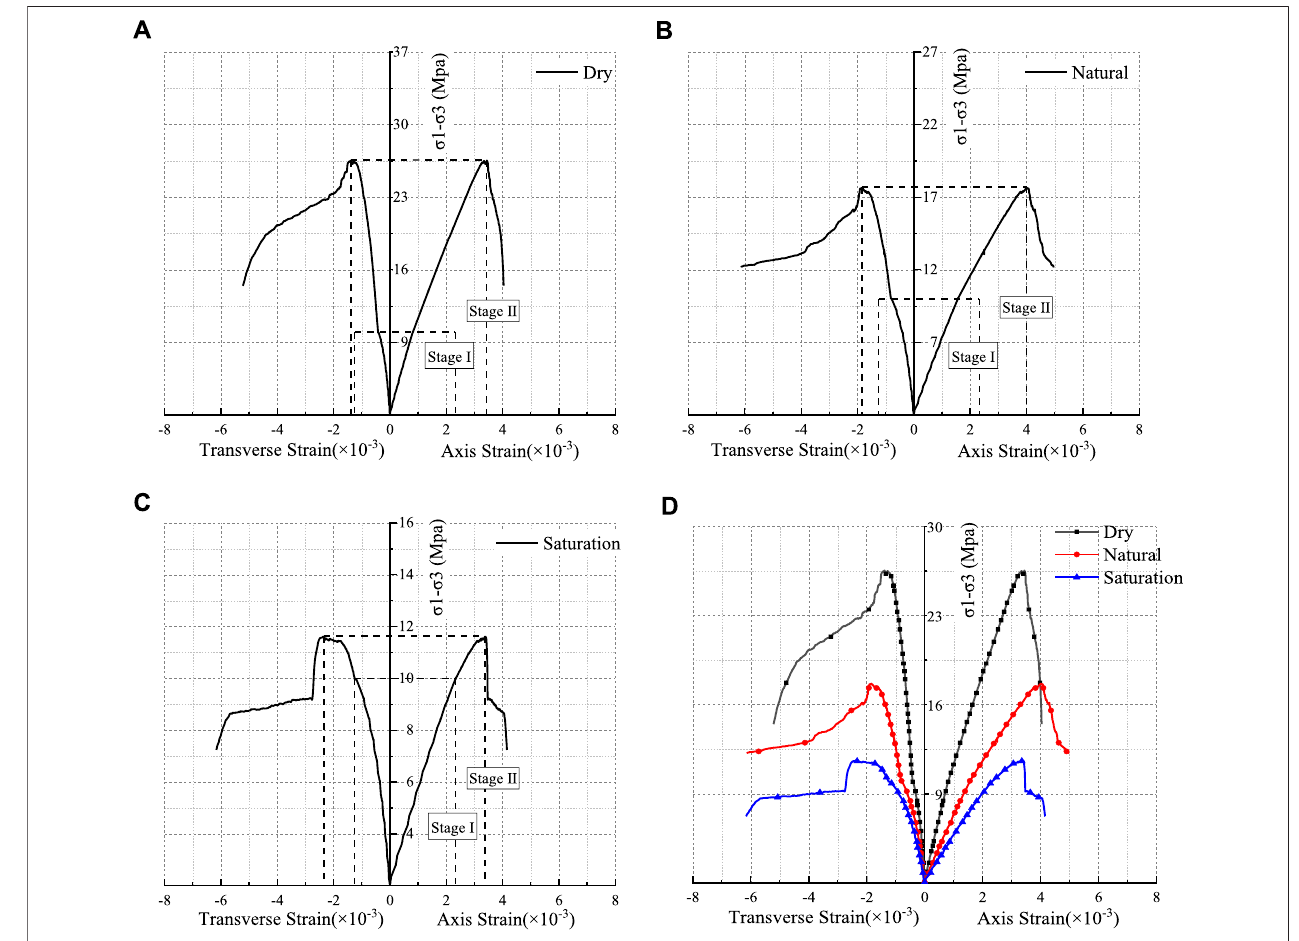
FIGURE 9 | Specimen stress – strain curve under different water content. (A) Dry curve; (B) natural curve; (C) saturation curve; and (D) comparative curves.